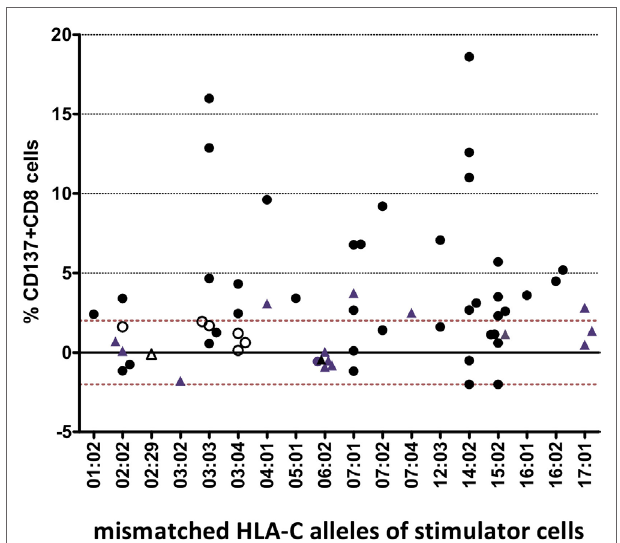
FigUre 1 | heterogenous alloresponse tested by in vitro mixed lymphocyte reaction (Mlr)/flow cytometry assays in 63 responder/stimulator cell combinations that were characterized by a single hla-c mismatch . The mismatched HLA-C allele of the stimulator cells and the % Δ CD137 + CD8 + cells induced after restimulation at day 14 are indicated (see Materials and Methods). The cutoff of 2% Δ CD137 + CD8 + cells is indicated by the dashed line. Activation of CD8 + NK cells (ranging between 0.2 and 1.2% CD8 + CD56 + CD137 + cells, results not shown) was not taken into consideration. Overall, 24 different shared HLA-A~B~DRB1~DQB1 haplotypes were tested (data not shown) . Twelve MLRs were repeated but dotted as single mean % Δ CD137 + CD8 + values. Black dots represent MLRs with HLA-C MMs located in α 1/ α 2 domains and HLA-DPB1 MMs. Blue triangles represent MLRs with HLA-C MMs located in α 1/ α 2 domains and matched HLA-DPB1. Open circles represent MLRs with C*03:03/03:04 MMs